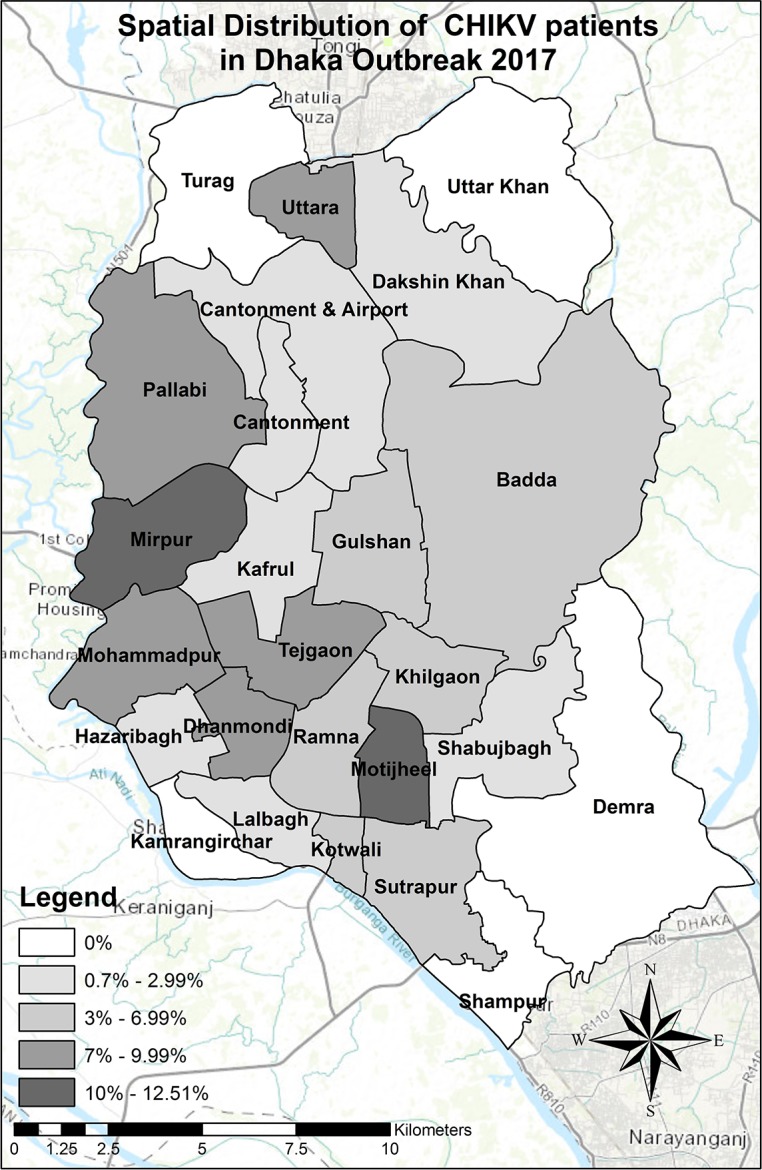
Spatial distribution of 855 patients out of 1326 CHIKV infected patients in Dhaka city.The remaining 471 patents were not interested to disclose their address during the interview. Data presented in this Figure as % of total patients had no reservation to share their residential address (n = 855).